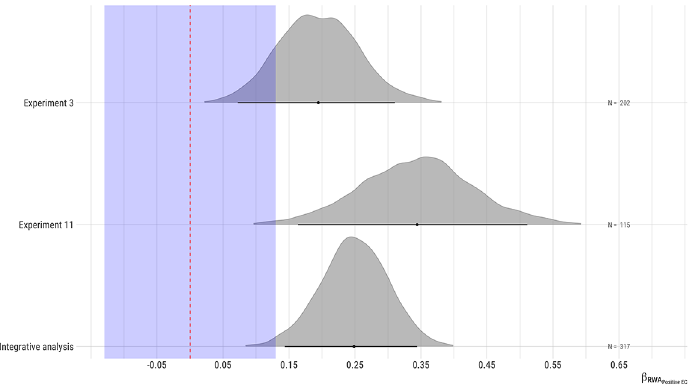
Note. The purple area corresponds to a region of practical equivalence where the values are considered equivalent to 0 (Kruschke, 2018). More information can be found in the Supplementary Materials.